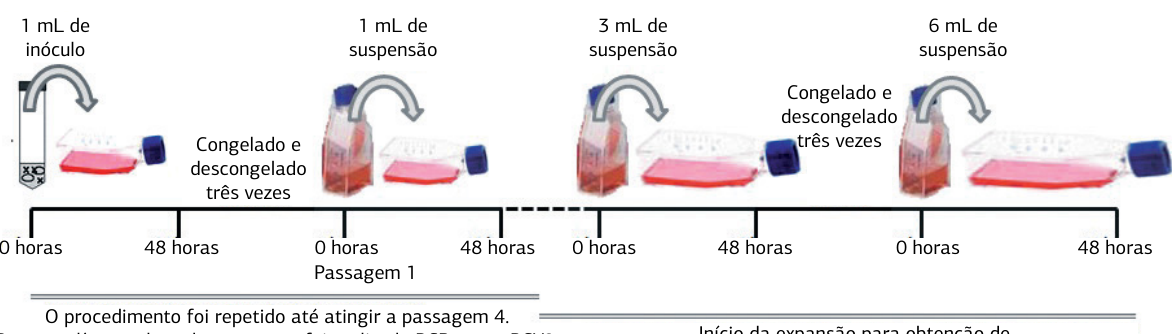
Figura 1. Ilustração do procedimento de isolamento e expansão de PCV2b em linhagem de célula de macrófago